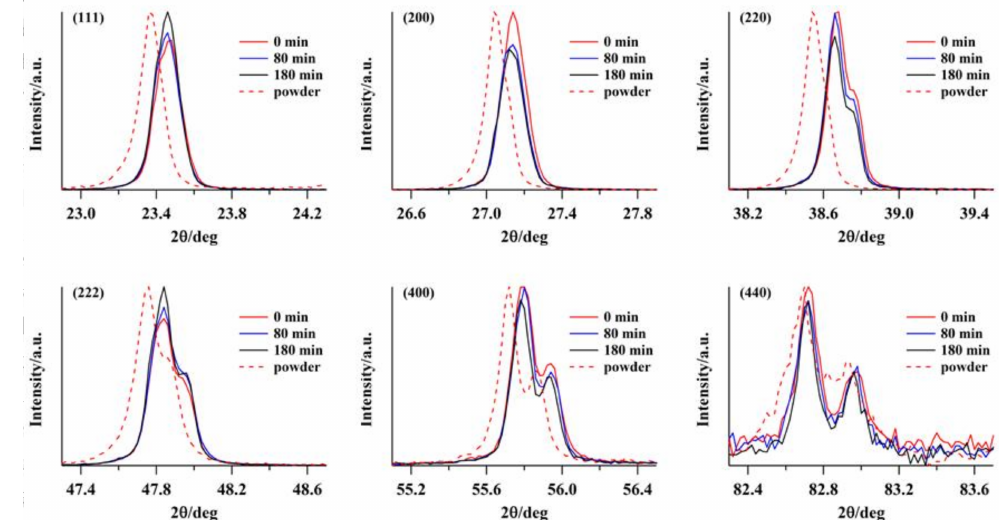
Figure 2. Time-dependent variations in X-ray diffraction (XRD) patterns of alkali halide KBr disk and KBr microcrystalline powder (dotted lines), with several peaks, i.e., (111), (200), (220), (222), (400), and (440), under exposure to air (40-min intervals). XRD patterns (0, 80, and 180 min) selected from interval data are indicated.